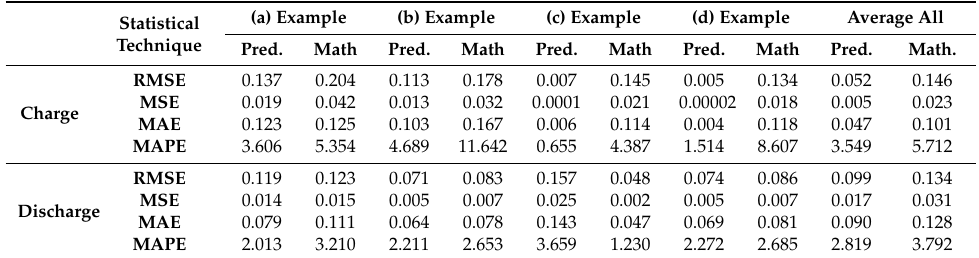
Table 5. Obtained statistical errors from prediction and electro-mathematical models on three described tests and the average of 36 tests.